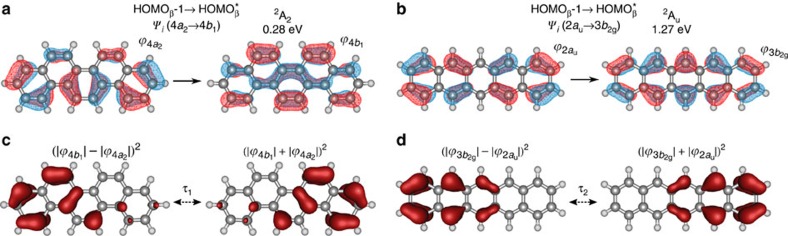
Electronic π→π* excitations and excited π-electron dipolar distributions.(a,b) Vibronically active one-electron configuration excitations Ψi(4a2→4b1) and Ψi(2au→3b2g) involving the spin-orbital π wavefunctions ϕ4a and ϕ4b of picene+ and spin-orbital π wavefunctions ϕ2au and ϕ3b2g of pentacene+, respectively. The two electronic configurations describe excited π states (Supplementary Tables 1 and 2) that mix into the ground state Ψo (0 eV). The symmetry product rule Γ(Ψo) × Γ(∂H/∂Q) × Γ(Ψi) determines the coupling excited states. For picene+, the vibronic operator ∂H/∂Q transforms as ν84, hence Γ(∂H/∂Q)=b2(y), and Γ(Ψo)=b1 which leads to excited-state wavefunctions Ψi of a2 symmetry. Similarly for pentacene+, the symmetry of excited states promoting Π-fluxes along ν85 is au. (c,d) Probability spatial distributions of the excited π-electron density that oscillates between extreme values (|ϕ4b|−|ϕ4a|)2 and (|ϕ4b|+|ϕ4a|)2 in picene+ and extreme values (|ϕ3b2g|−|ϕ2au|)2 and (|ϕ3b2g|+|ϕ2au|)2 in pentacene+. The π spin-orbital energy gaps (Fig. 1b) determine the oscillation periods (τ1, τ2) on the order of a few femtoseconds. The two-carbon and one-carbon density centers determine, respectively, the bonding and anti-bonding electronic characters of the excited spatial redistributions. Molecular structures and spin-orbital wavefunctions from B3LYP/6-311G** calculations.